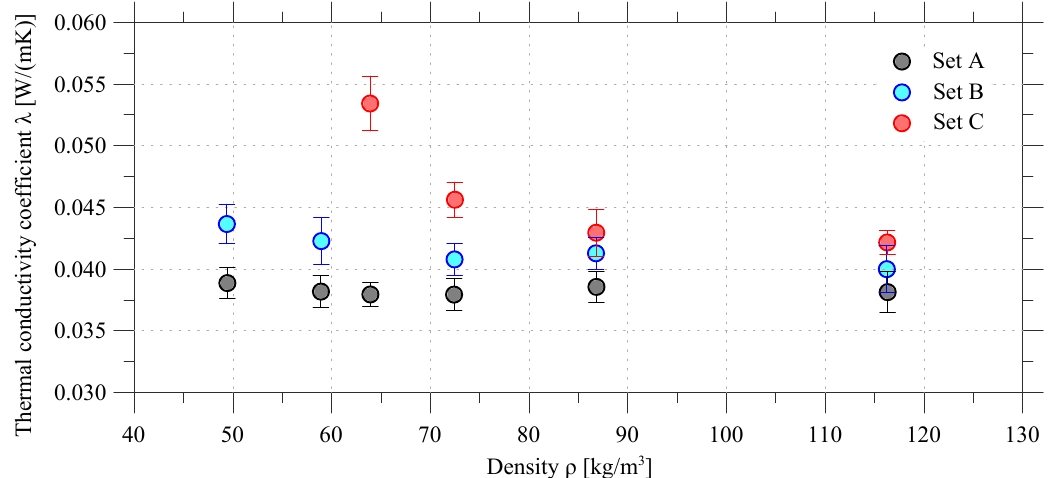
Figure 6. Graph of the thermal conductivity coefficient as a function of the bulk density of